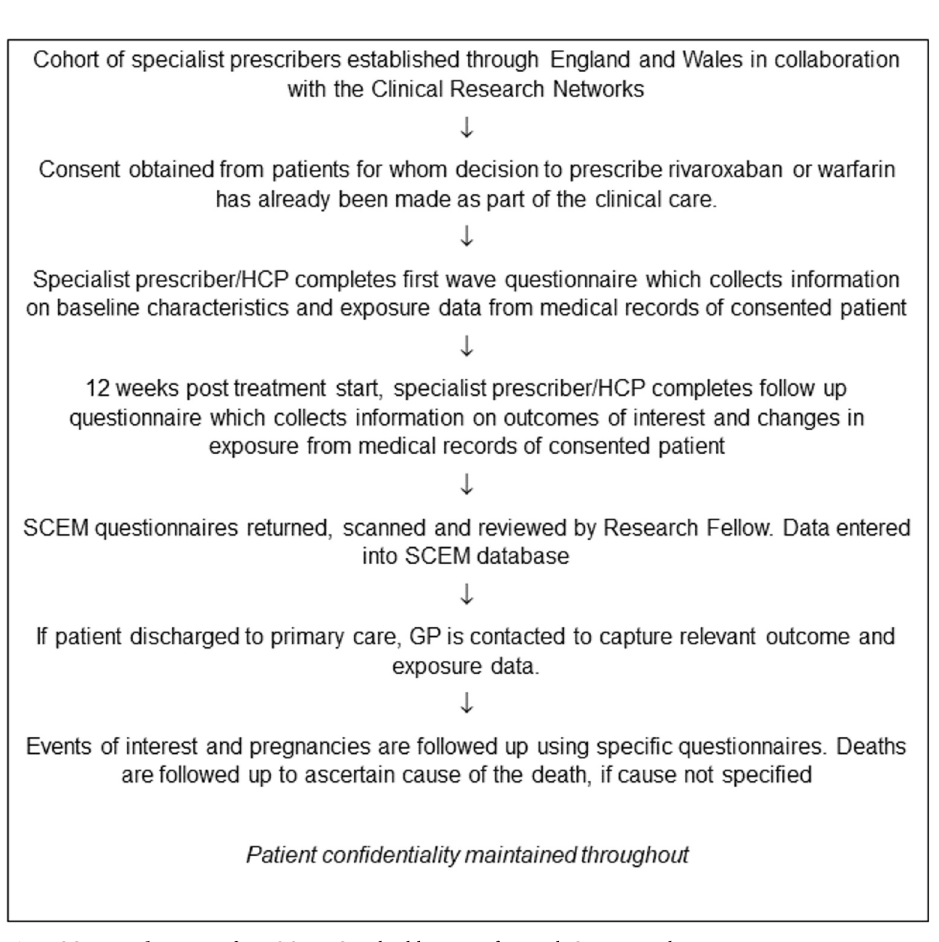
Fig 1. SCEM study process for ROSE. HCP = healthcare professional, GP = general practitioner.